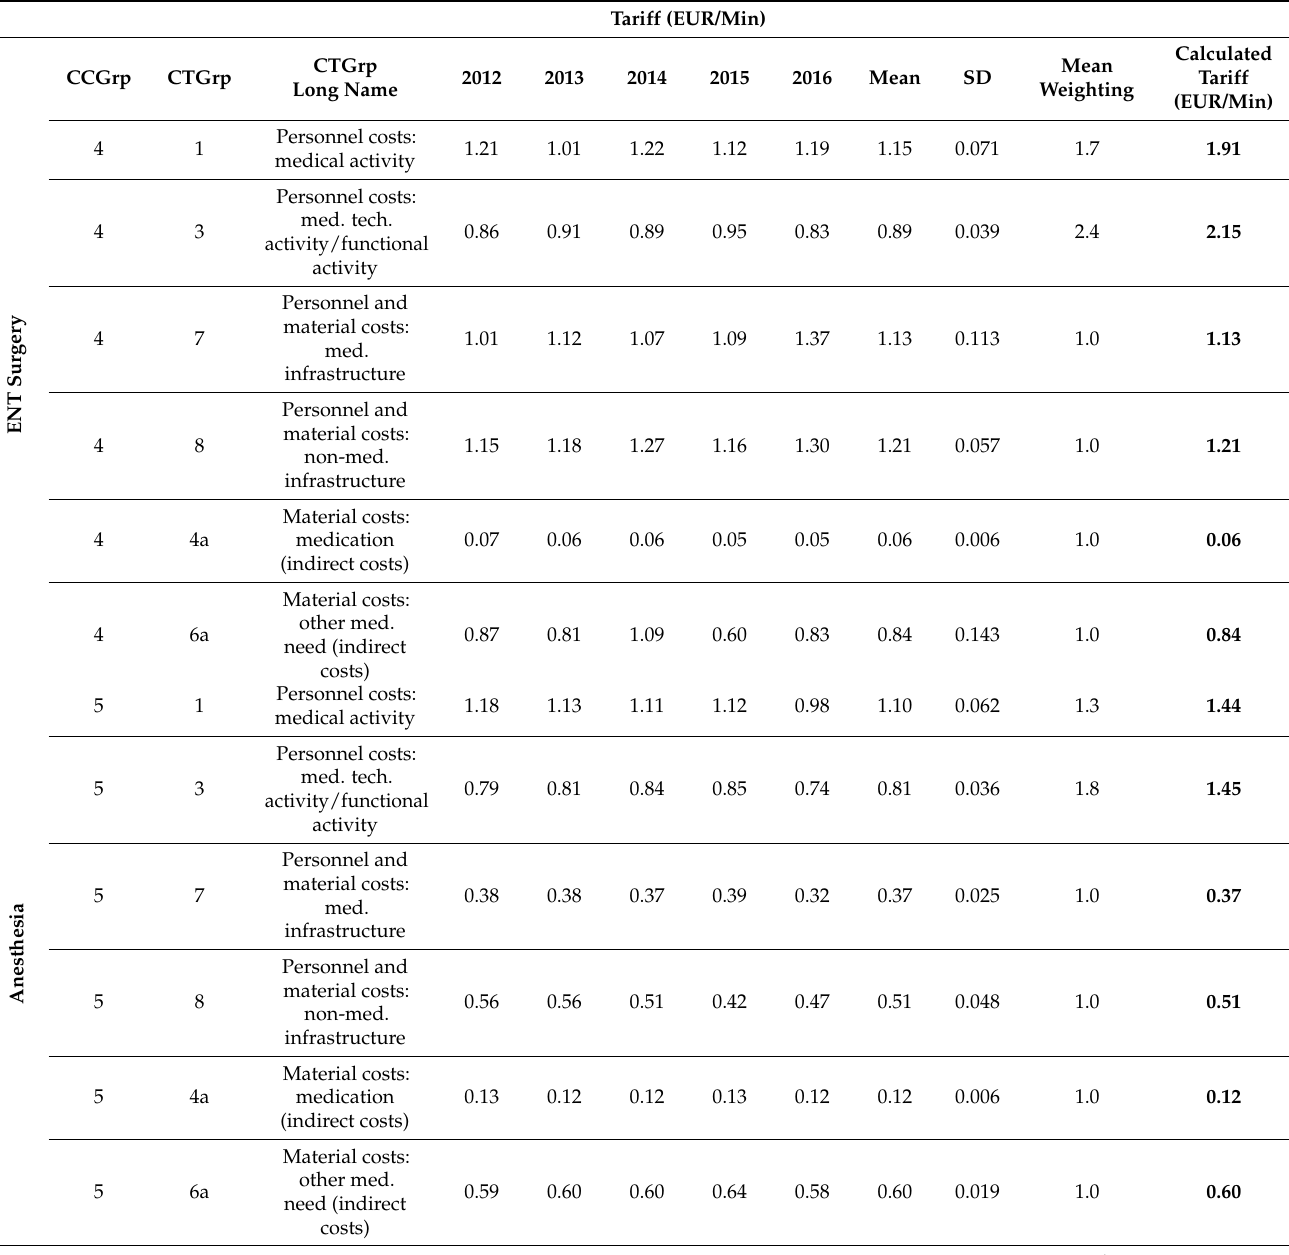
Table 8. Results—cost rate